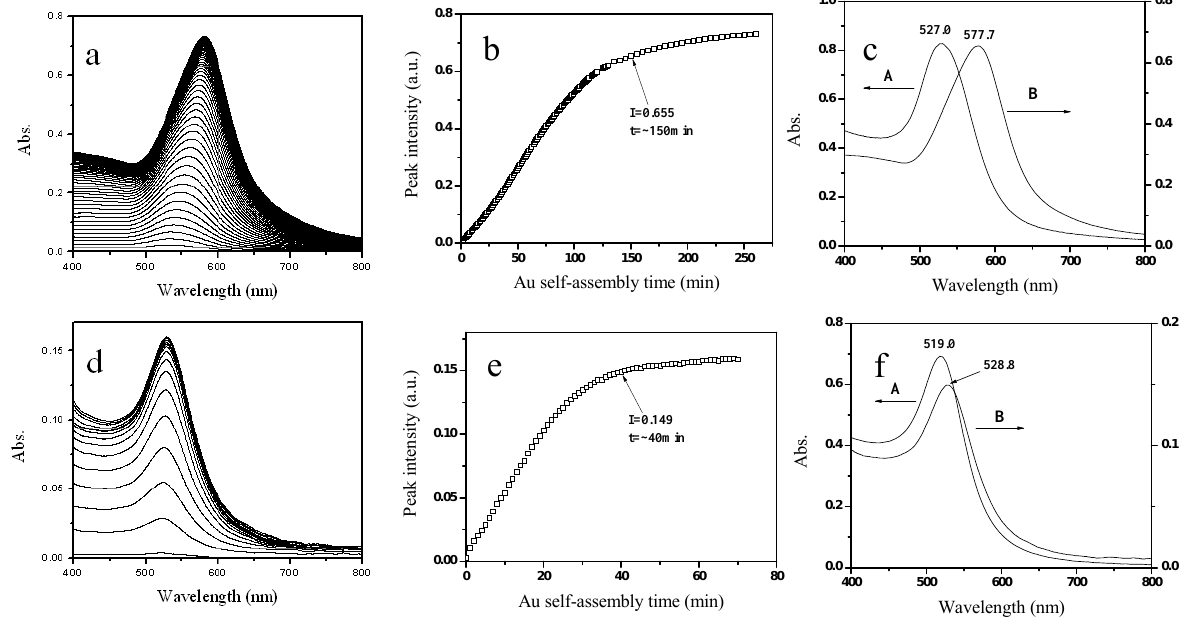
Figure 2. The absorption spectra of Au NP assembled films at different assembly time. (b) and (e); the LSPR peak intensity as a function of different assembly times. The assembly time is about 150 min for 48-nm Au and 39 min for 23-nm Au. (c) and (f); the absorption spectra before (A) and after the Au NP assembly (B). (a)-(c); 48-nm Au. (d)-(f); 23-nm